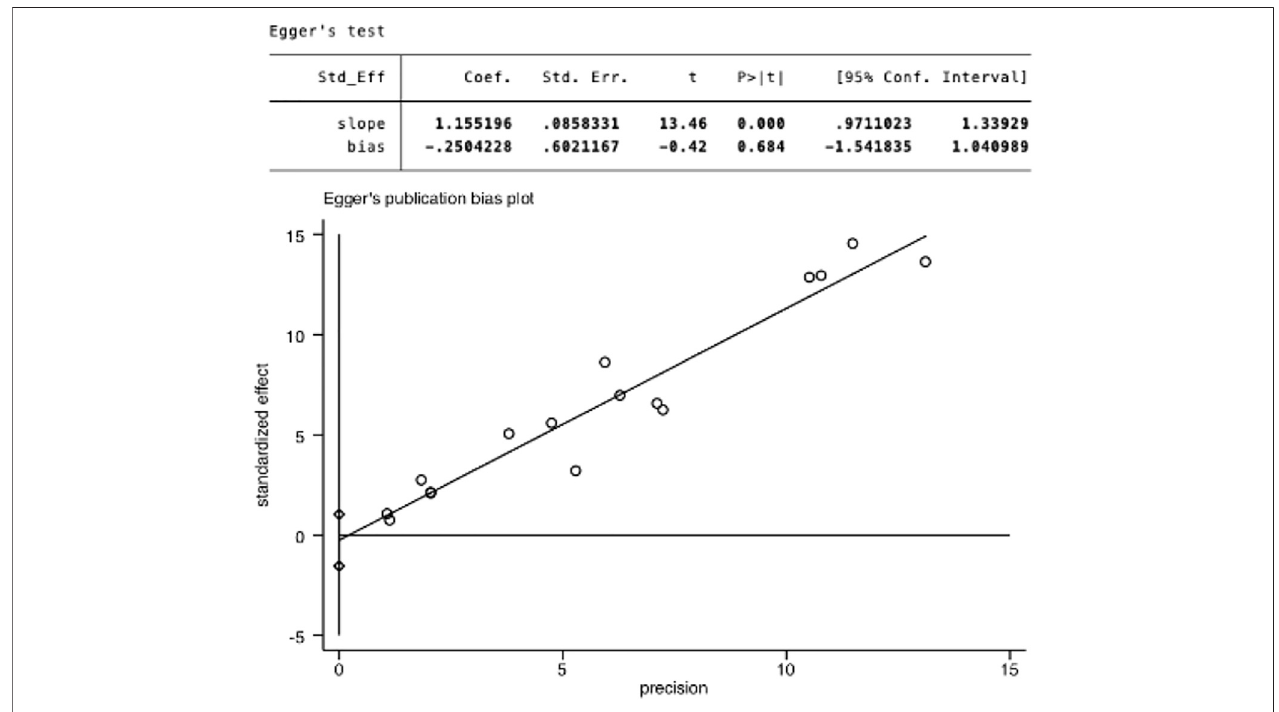
FIGURE 8 | Egger ’ s linear regression test of publication